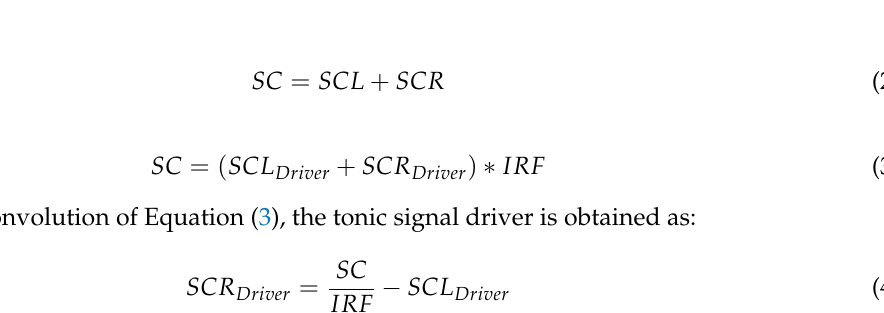
Figure 2. Flowchart of the deconvolution process